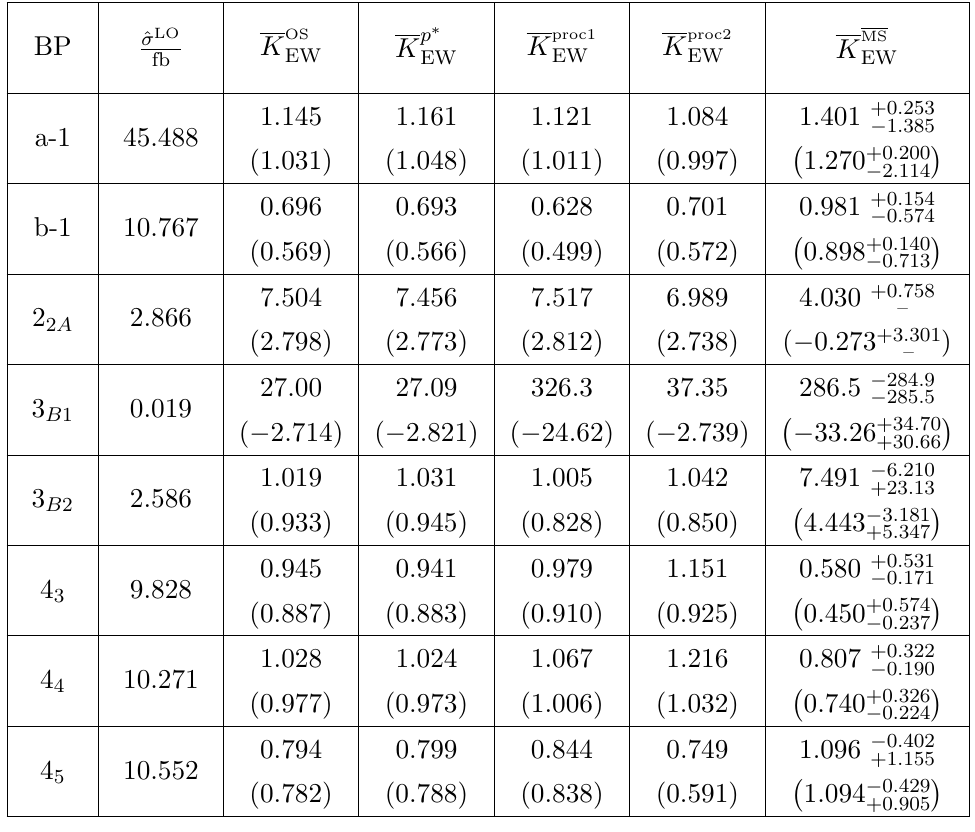
Table 6 . The NLO electroweak K-factors for the process g + g H h for the 2HDM benchmark ! points (BP) that are not in the alignment limit are shown. They are de(cid:12)ned in table 2. The renormalization scale has been set to (cid:22) 0 as de(cid:12)ned in eq. (3.4) for the MS scheme. Both K NLO ((cid:12)rst EW value) and K NLO (in parentheses) are shown. The lower (upper) value of the MS result corresponds EW to the change when taking (cid:22) 0 = 2 (2 (cid:22) 0 ) as renormalization scale. The lower MS uncertainty for BP 2 2 A is not shown, since the RGEs (3.5) do not allow for a stable solution, see also (cid:12)gure 9